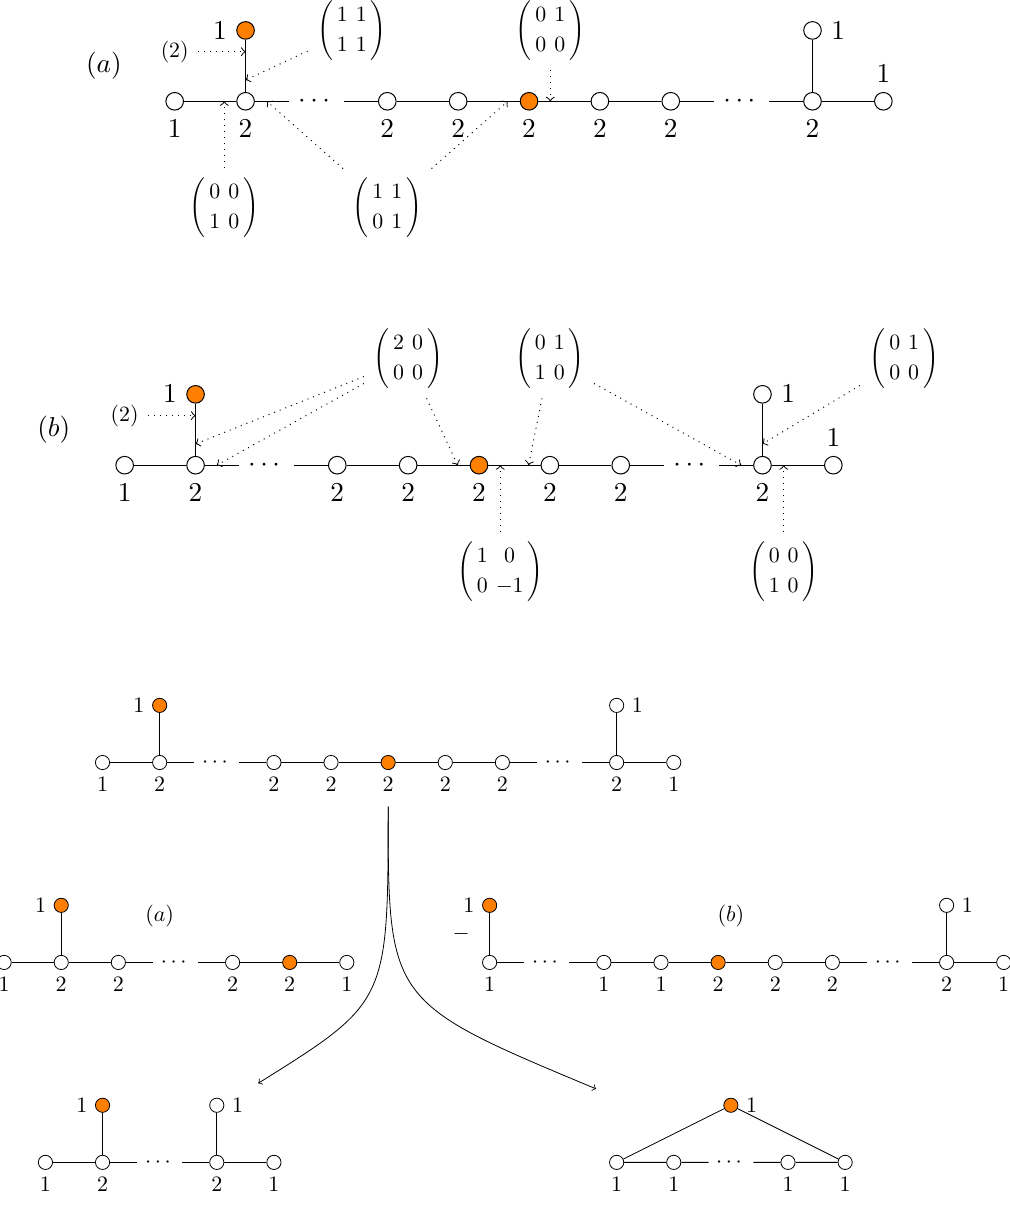
Figure 7 . Two solutions for D type and corresponding subtractions. The subtractions realize the splitting D . The orange node in the middle is the k th starting from the left. This n → A k − 1 D n − k reproduces the subtraction (2.34) obtained from the brane